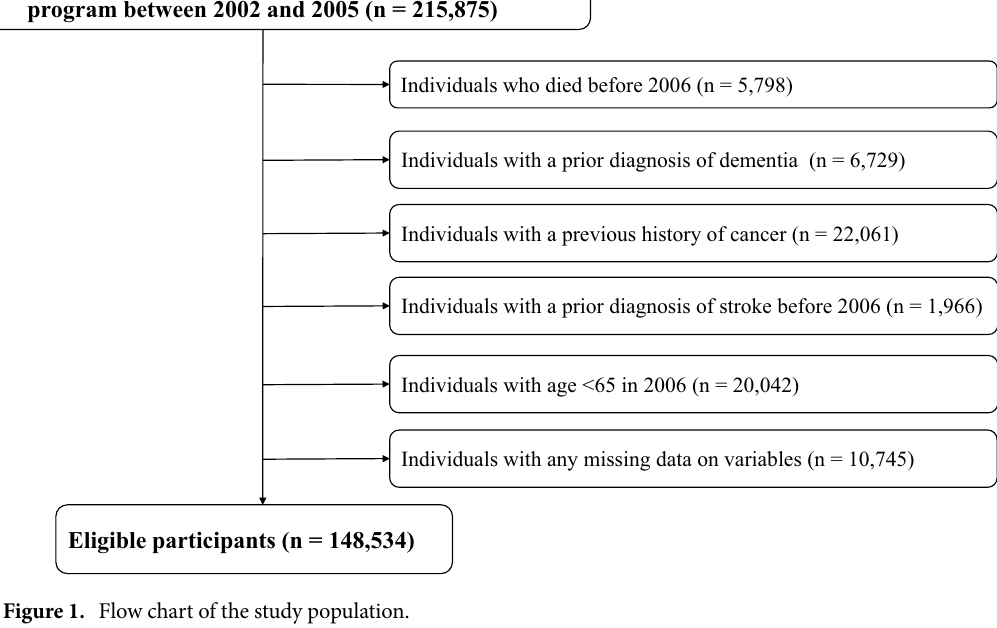
Figure 1. Flow chart of the study